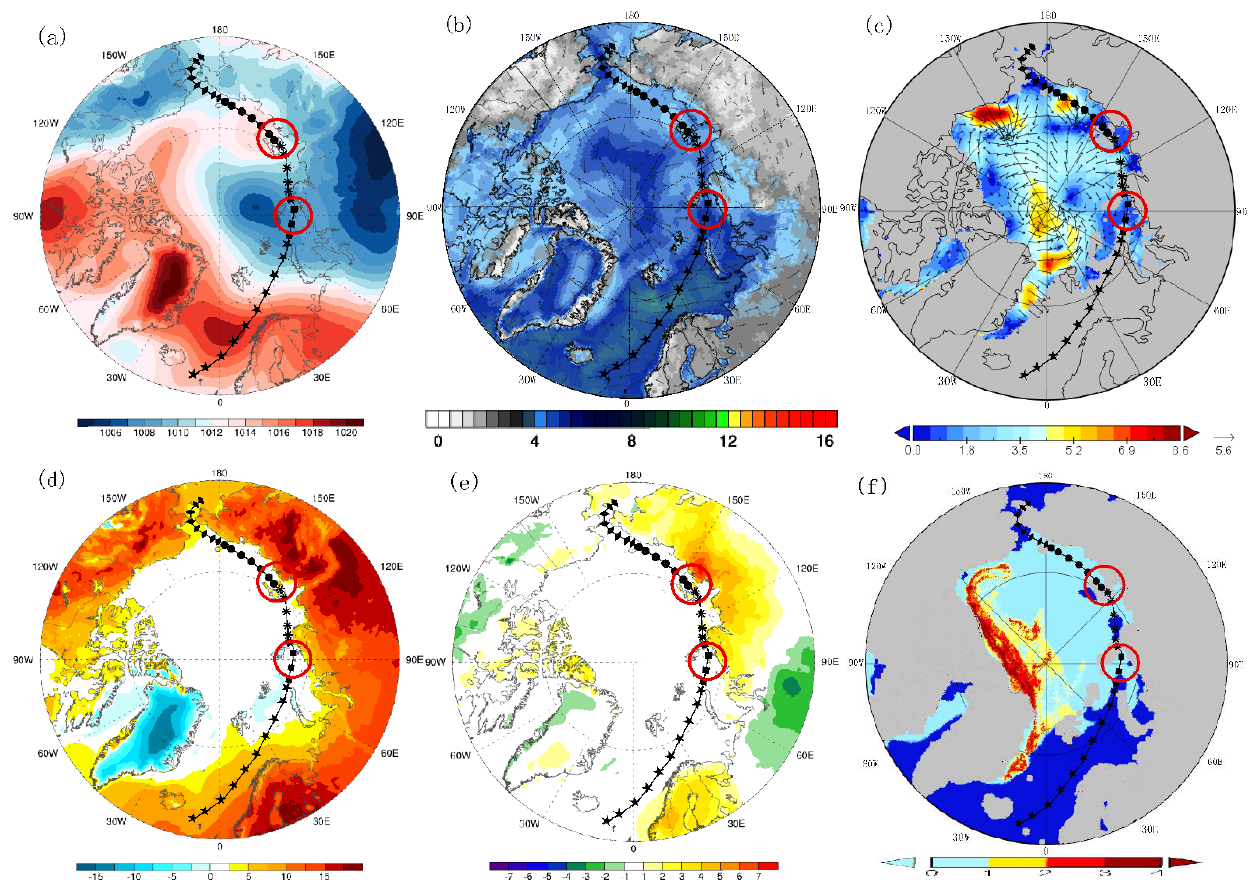
Figure 18. Distribution map of ( a ) sea level pressure (unit: hpa); ( b ) wind field (unit: m −1 ); ( c ) sea ice movement (unit: m −1 ); ( d ) temperature (unit: centigrades); ( e ) temperature anomaly (unit: centigrades) and ( f ) sea ice age (unit: year) in the Arctic summer in June 2020. (The red circles represent the special areas.)